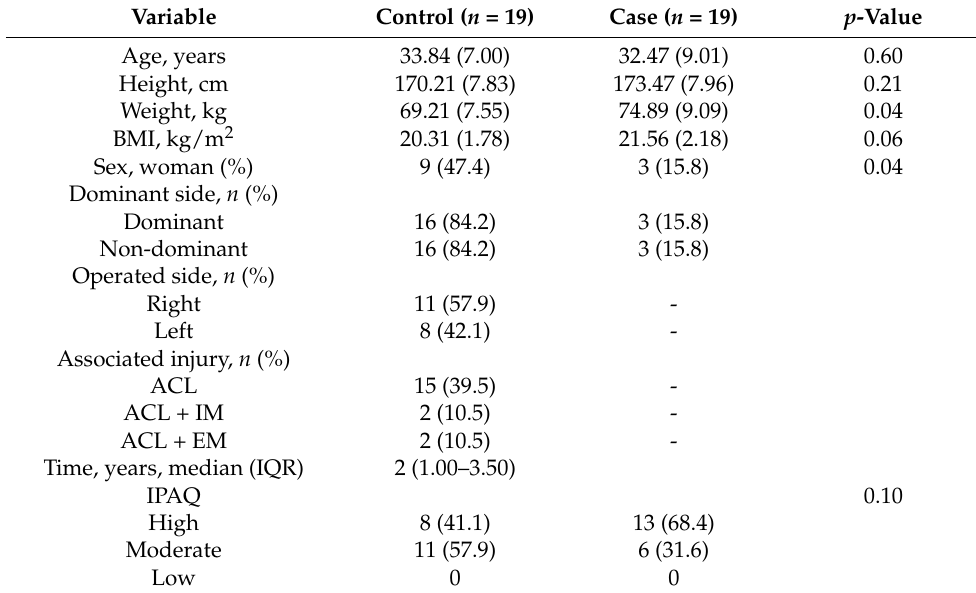
Table 1. Demographics characteristics.